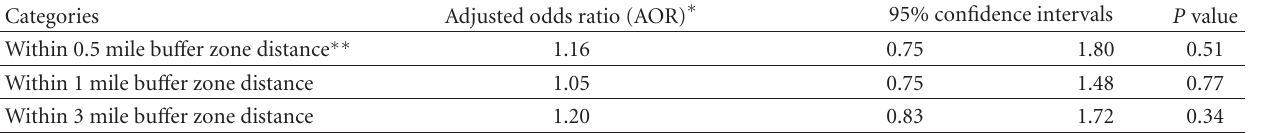
Table 4: Relationship between distance to recreation facilities and leisure physical